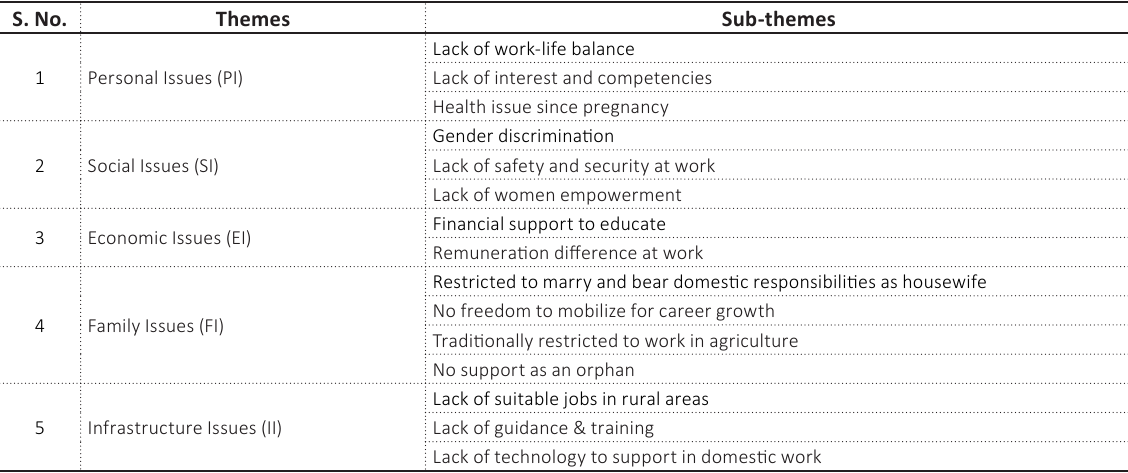
Table 2. Themes and sub-themes identified through the interview S.